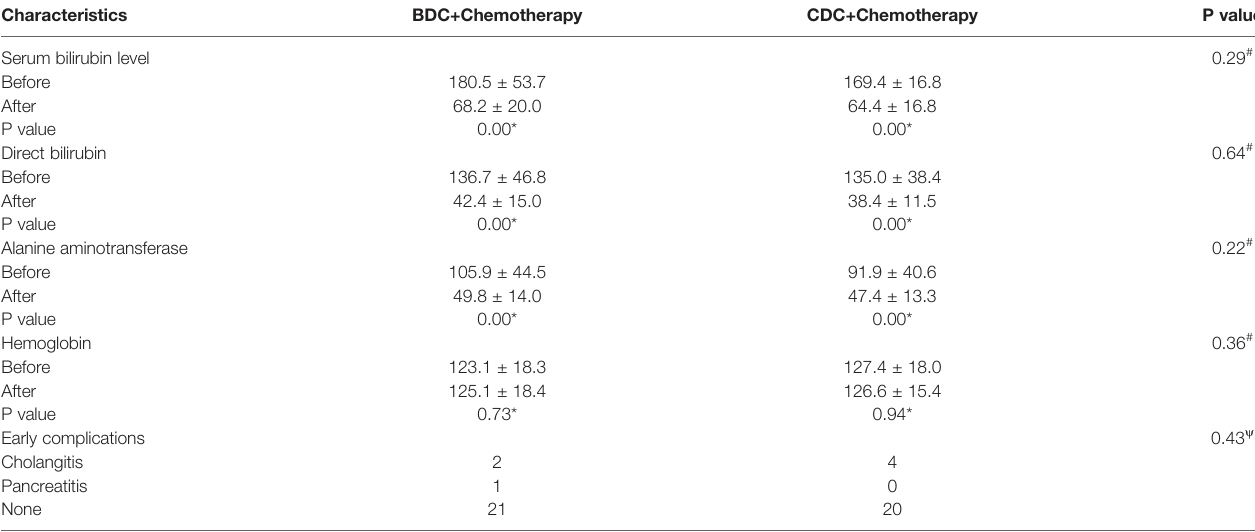
TABLE 2 | Laboratory values and early complications in both groups.